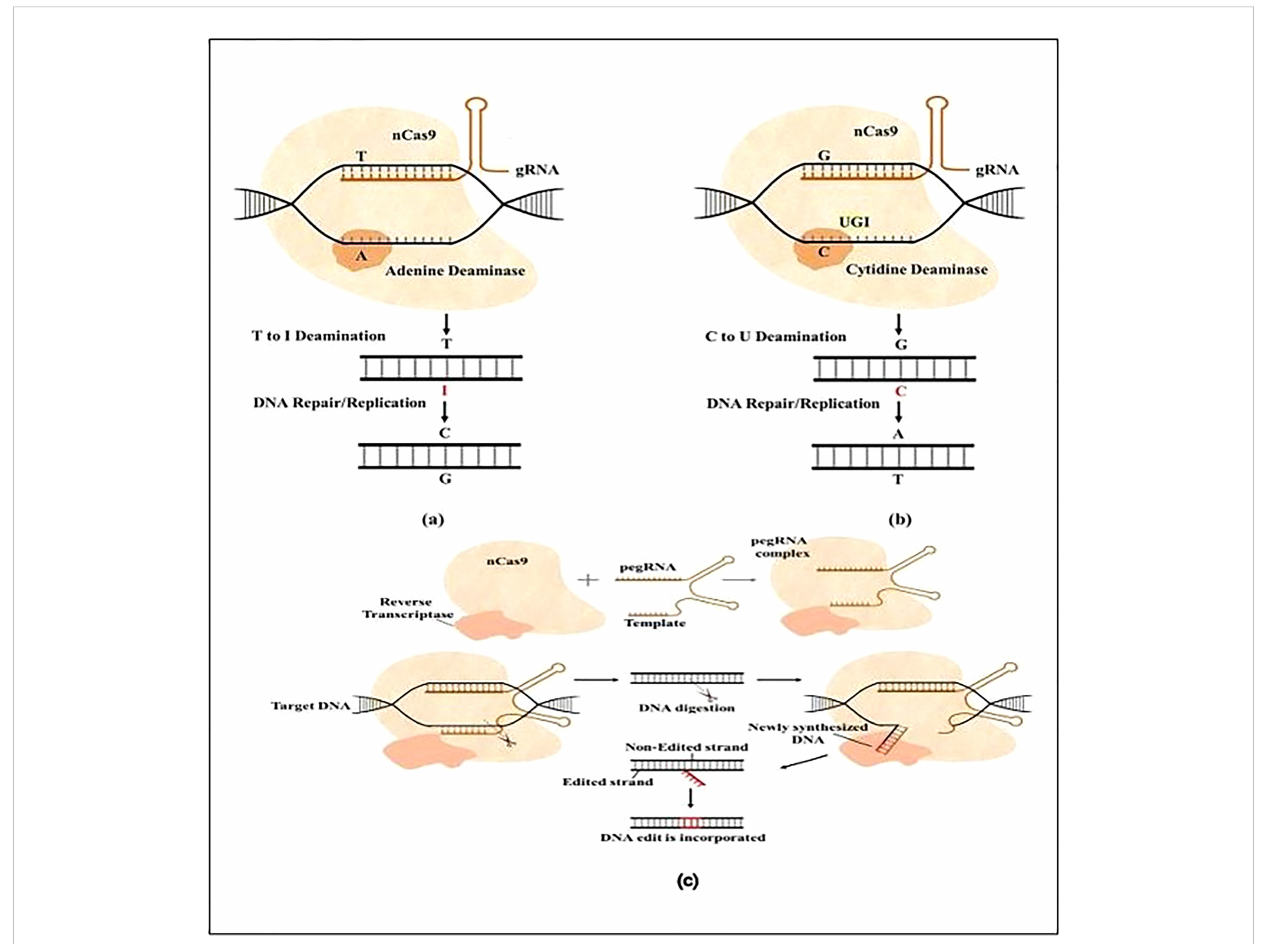
FIGURE 3 Schematically shown base modi fi cation with Nickase Cas9(nCas9), (A) The ABE system catalyzes the conversion of adenine into guanine via nCas9 and adenine deaminase. Adenine is deaminated by ABE to inosine (I), changing T-A to T-I. Repair machinery interprets I as G and repairs T-I as C-G; (B) the CBE system uses nCas9 and cytidine deaminase to catalyze the conversion of cytosine to uridine. UGI (uracil glycosylase inhibitor) inhibits U: G mismatch from being repaired back to C: G, causing U to ultimately change into T; (C) Prime editing is illustrated in a schematic by